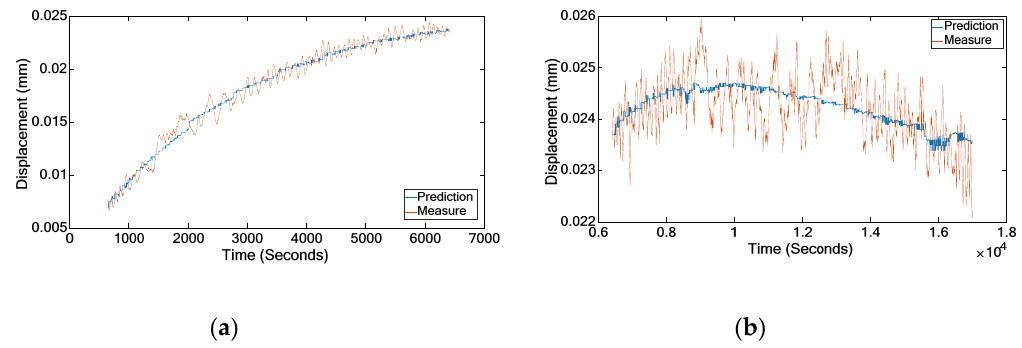
Figure 8. Fit Diagram of the rise time and stable time of the optimal parameter spindle thermal displacement model. In ( a ), the di ff erence of actual displacement value and predicted displacement value is within 19 µ m. In ( b ), the di ff erence between actual displacement value and predicted displacement value is within 15 µ